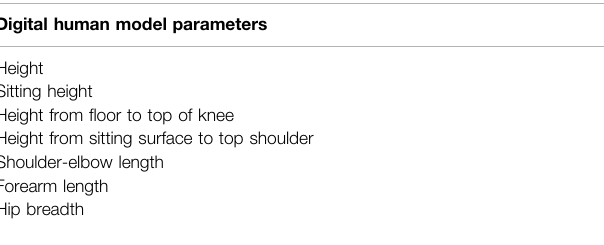
TABLE 1 | Adjustable DHM